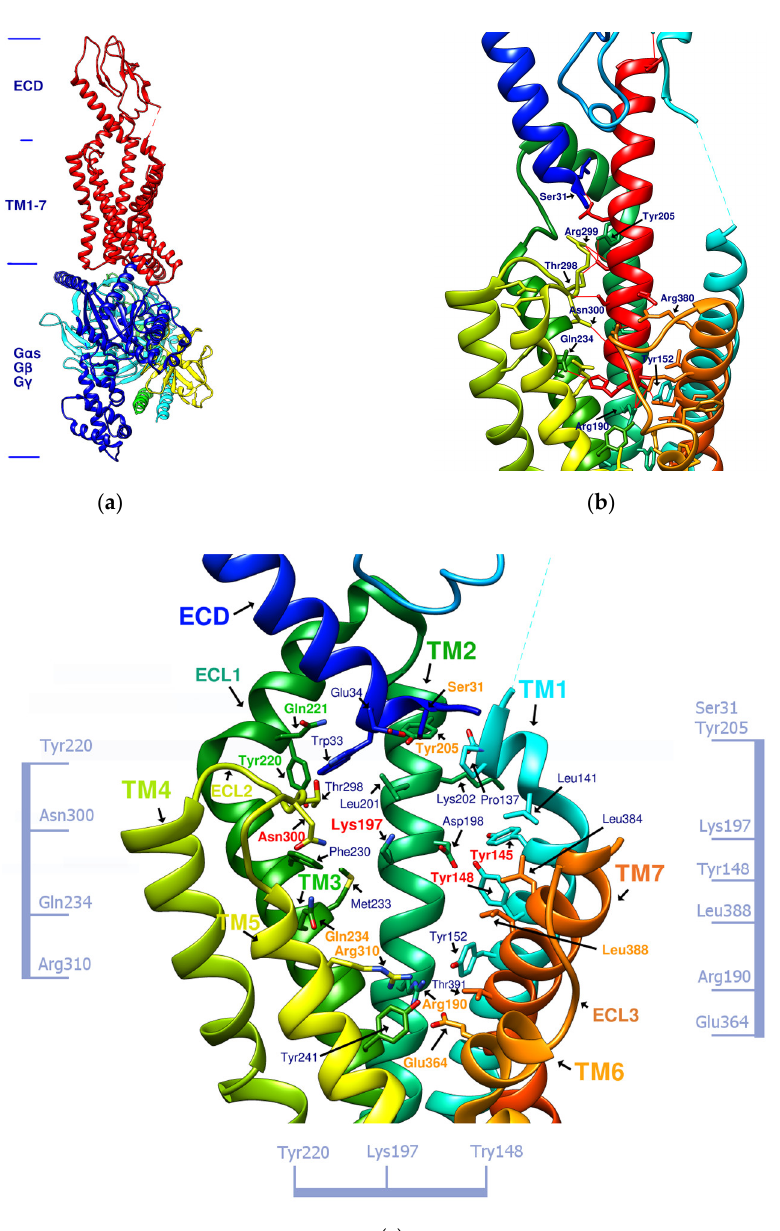
Figure 1. ( a ) GLP-1R and the G-protein (PDB:6X19). ( b ) GLP-1 (red alpha helix, the original ligand of GLP-1R)/GLP-1R (transmembrane region) complex (PDB:6X18). ( c ) Important amino acid residues in the transmembrane region (TM1-7) of GLP-1R (PDB:6X19). Ser31, Tyr205, Gln234, Arg310, Arg190, Glu364, and Leu388, shown in orange, delineate the approximate boundaries of the active site. Asn300, Lys197, Tyr148, and Tyr145, shown in red, are the residues involved in the important hydrogen bonds and π–π interaction network in the middle section. Tyr220 and Gln221, shown in green, are located on ECL1. The labeling of these important amino acids is based on the related studies of GLP-1 agonists [7,21]. The amino acids marked on the vertical axis on both sides and the horizontal axis on the bottom can be used as reference axes for analyzing the configuration of GLP-1R agonists. TM2 can also serve as a reference axis for configurational analysis of GLP-1RAs.